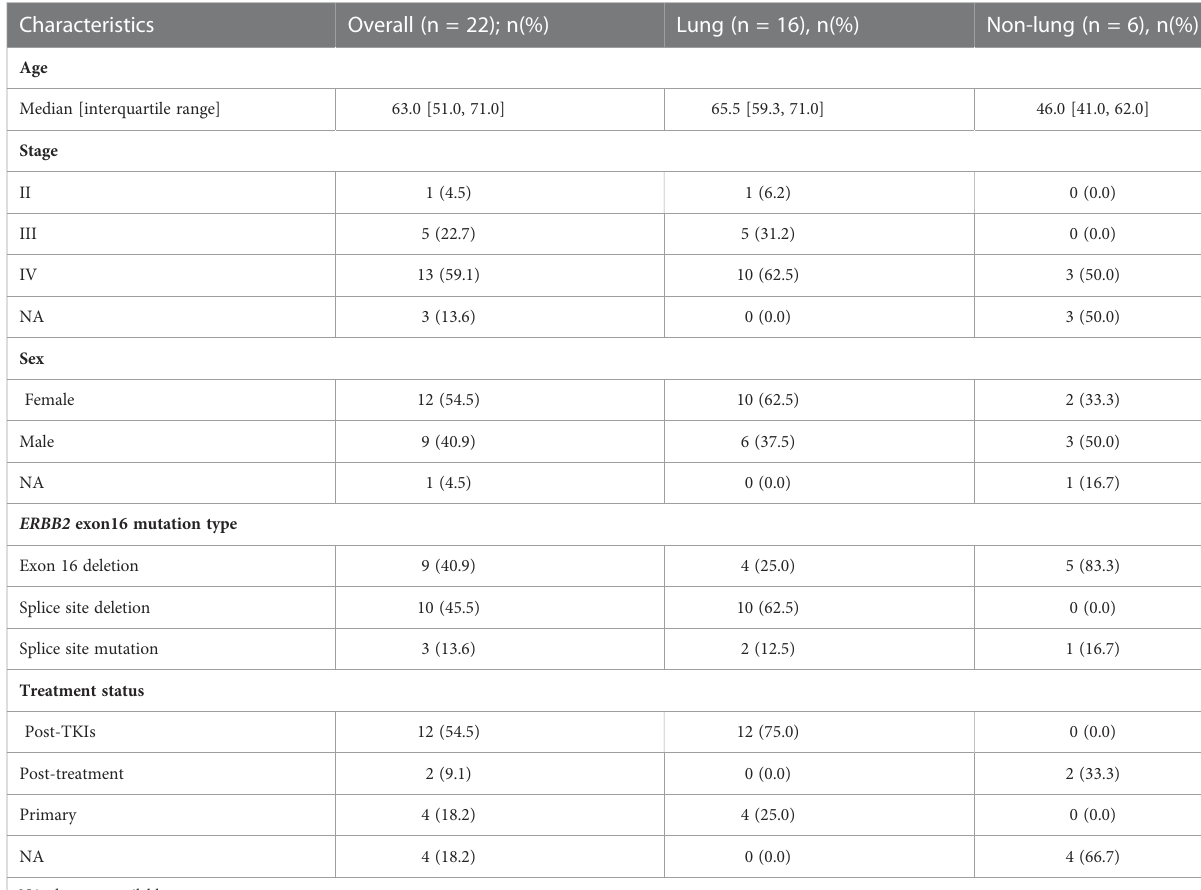
TABLE 1 Clinical characteristics of the 22 patients detected with ERBB2 exon 16 mutations in Cohort 1.